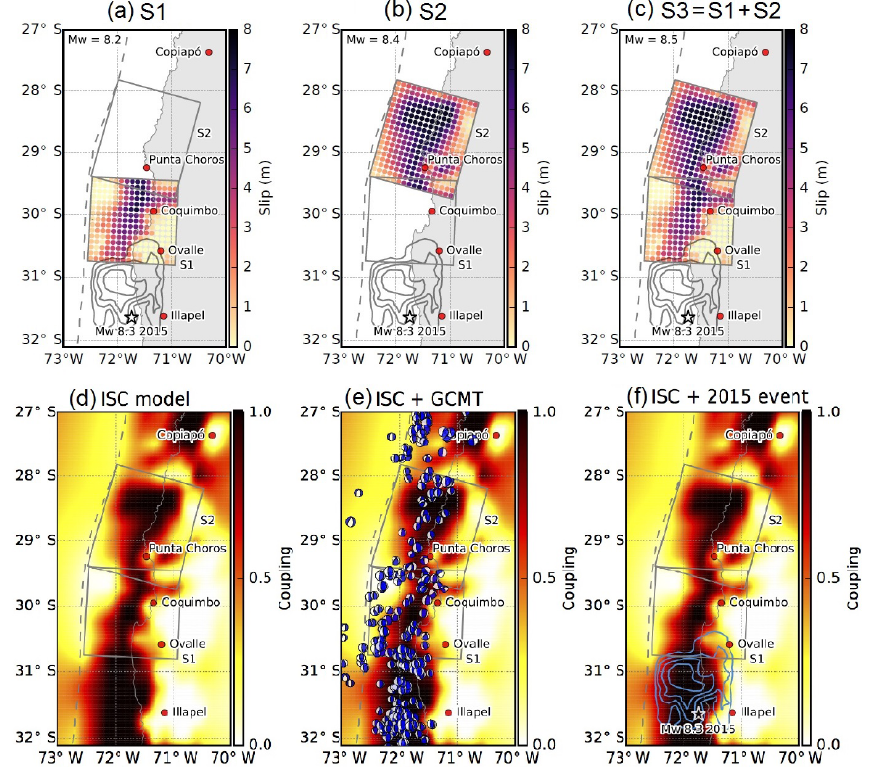
Figure 10. Upper panels show slip distributions along scenario source models. The gray rectangles outline each scenario source segment. The moment magnitude for each scenario source model is denoted in the top left of the corresponding panel. Lower panels show the inter- seismic coupling (ISC) model from Métois et al. (2016) (left panel), Global Centroid Moment Tensor (GCMT) solutions (center panel) and the inverted slip model from Okuwaki et al. (2016) (right panel), which were used to construct the scenario source models. The star denotes the epicenter of the 2015 Illapel earthquake determined by the National Seismological Center (CSN, for its initials in Spanish). The blue contours delimit the inverted slip distribution every 2.08m for the 2015 Illapel earthquake (Okuwaki et al.,